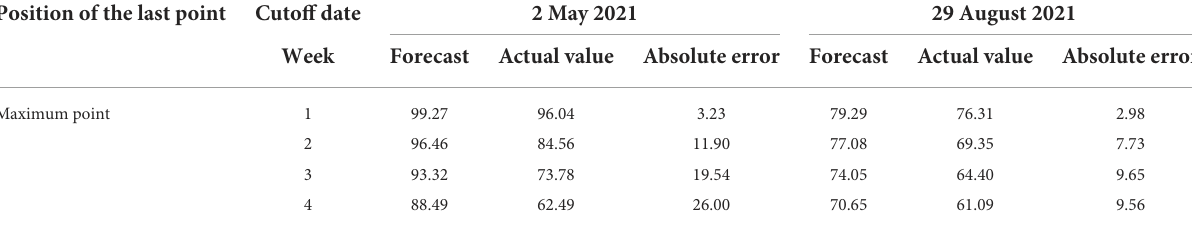
TABLE 7 Forecast result when the last point is at the maximum point. Position of the last point